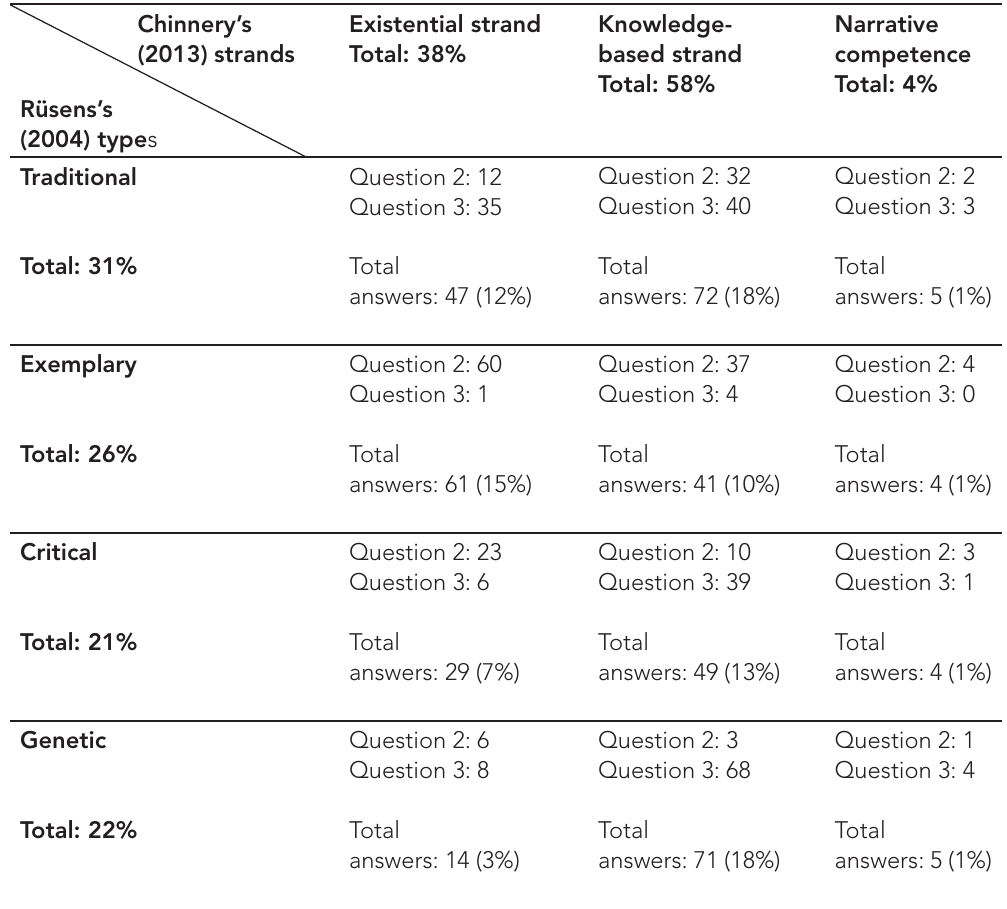
Table 2: Distribution of answers in the combined theoretical typologies of temporal orientation in relation to moral reflection (number of answers, and percentage of the total number of